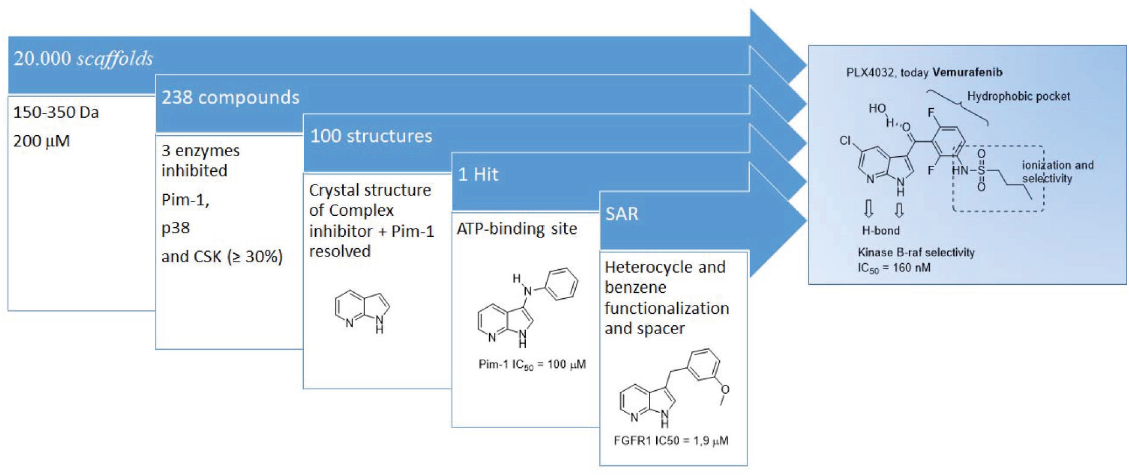
FIGURE 3 - Evolutive process of vemurafenib discovery from a fragment starting